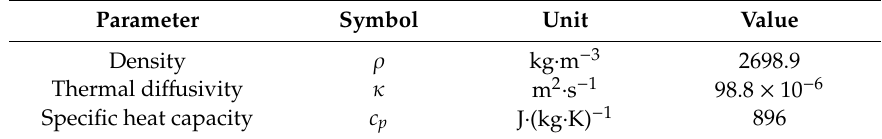
Table 1. Material properties of aluminum EN AW-5754 AlMg3